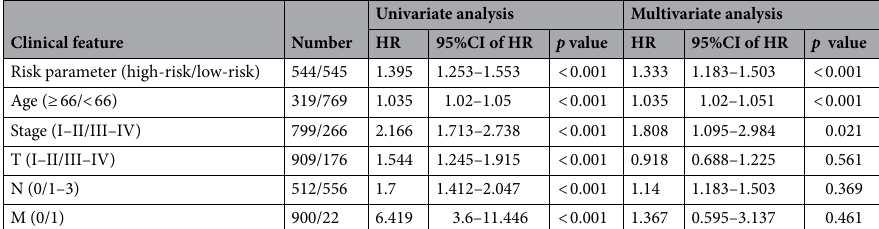
Table 4. Univariable and multivariable analyses for each clinical